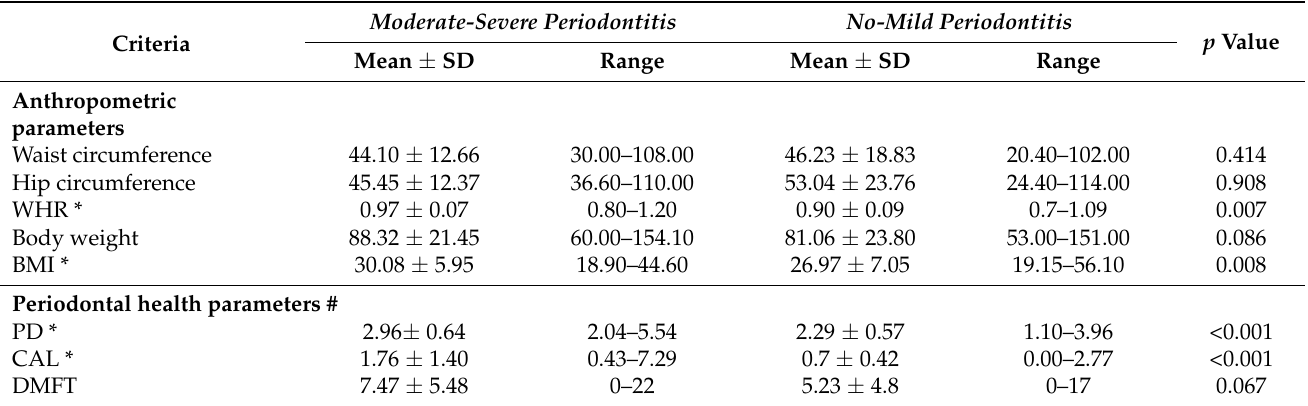
Table 2. Differences between participants with no-mild periodontitis versus moderate-severe peri- odontitis in parameters related to obesity and periodontal